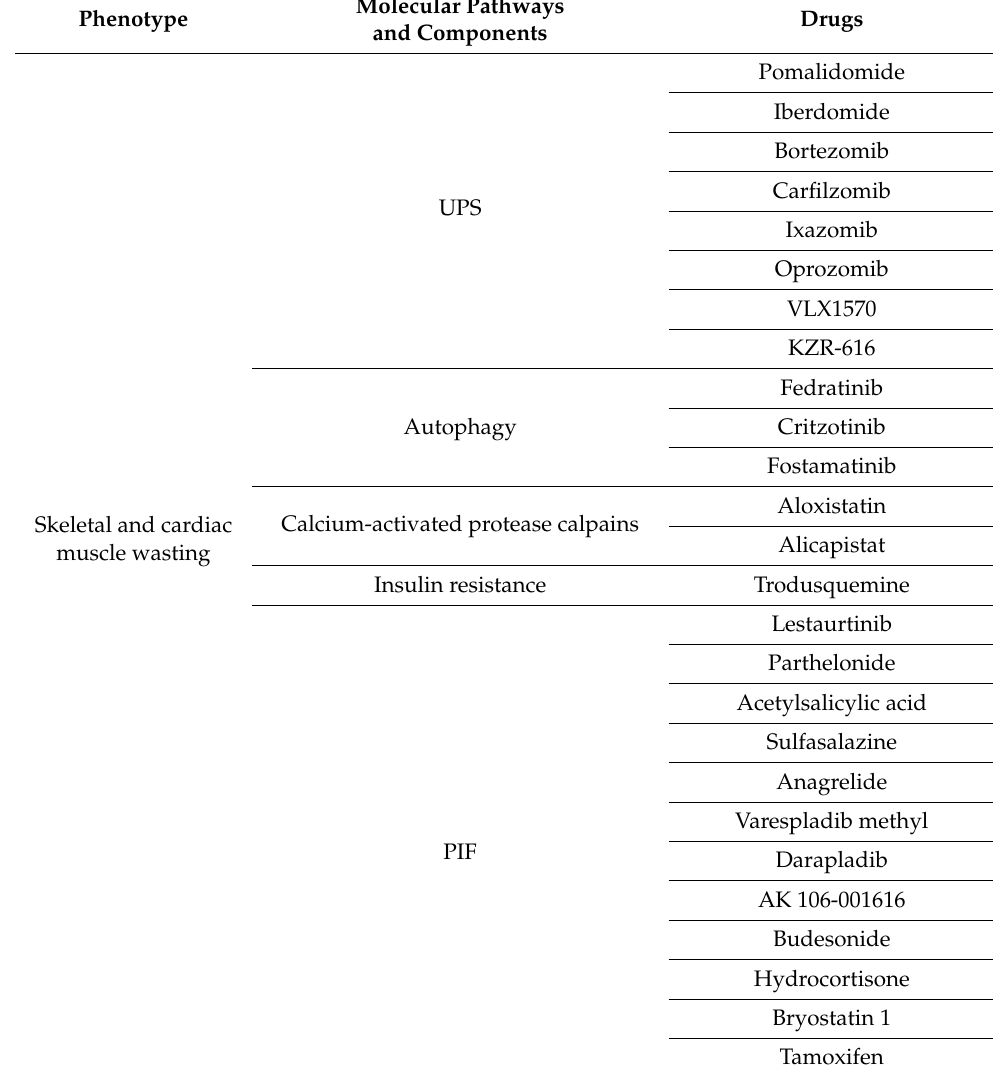
Table 3. Molecular pathways and respective drugs involved in skeletal and cardiac muscle